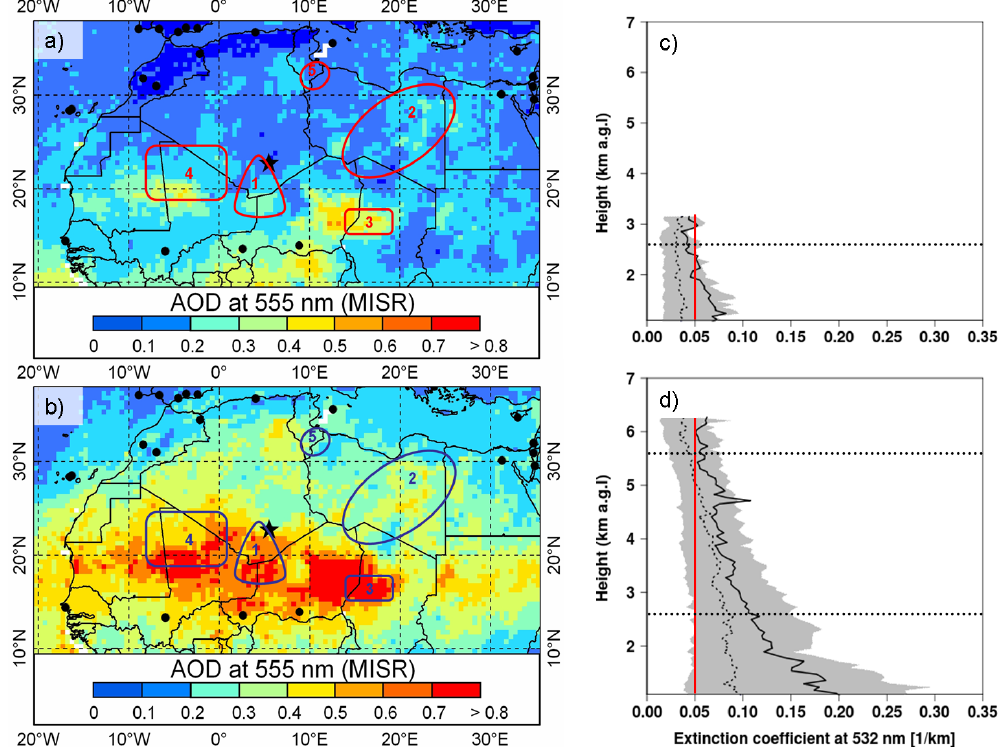
Figure 8. Averaged MISR AOD at 555nm (dimensionless blue/red scale) for the period 2007–2008 during (a) the dry season (from November to February) and (b) the wet season (from April to September). Geographical location of Tamanrasset (black star) in the Hoggar Mountains (Algeria) and present (2014) continuous monitoring AERONET stations (black dots) are indicated. Several potential dust sources, discussed in the text, have been identified (solid red/blue lines) and numbered as follows: 1, triangle formed by the Adrar des Ifoghas, Hoggar and Aïr massifs; 2, eastern Libyan desert; 3, Bodélé Depression; 4, western Sahara region; and 5, Libya–Tunisia border. Mean (black solid line) and median (black dashed line) CALIOP extinction coefficients at 532nm (km − 1 ) are displayed for the period 2007–2008 during (c) the dry season (43 available profiles) and (d) the wet season (95 available profiles) over Tamanrasset. Grey-shaded area shows the range of values between the 20th and 80th percentiles. The red line marks the threshold of pristine conditions (extinction coefficient <0.05 km − 1 ) . Significant height levels, except the ground level, for the CWT analysis (2600 and 5600ma.g.l.) are marked (black dotted